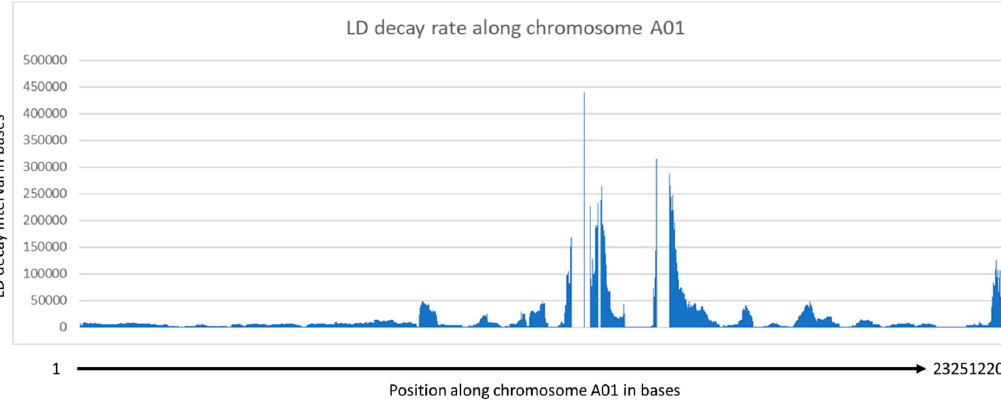
Figure 3. LD decay rate in bases along chromosome A01. Regions of highly repressed recombination among members of the population are observed as peaks.